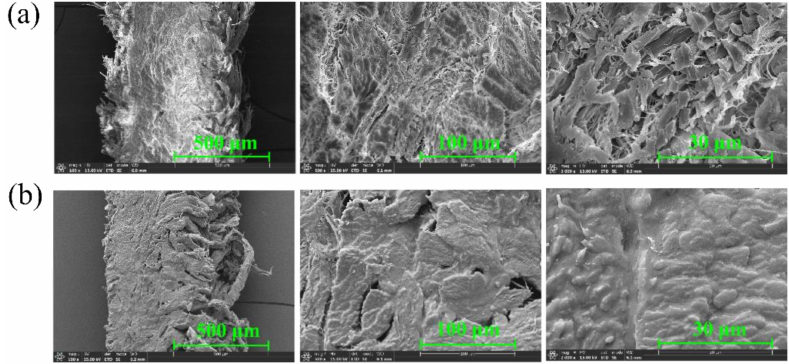
Figure 4. ( a , b ) SEM topography of the CFM ( a ) before and ( b ) after immersion in the ionic